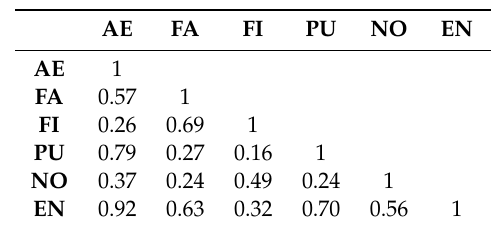
Table 4. Correlation among the six factors. Very weak correlations are highlighted in black, weak correlations in yellow, moderate correlations in blue, strong correlations in green, and very strong correlations in